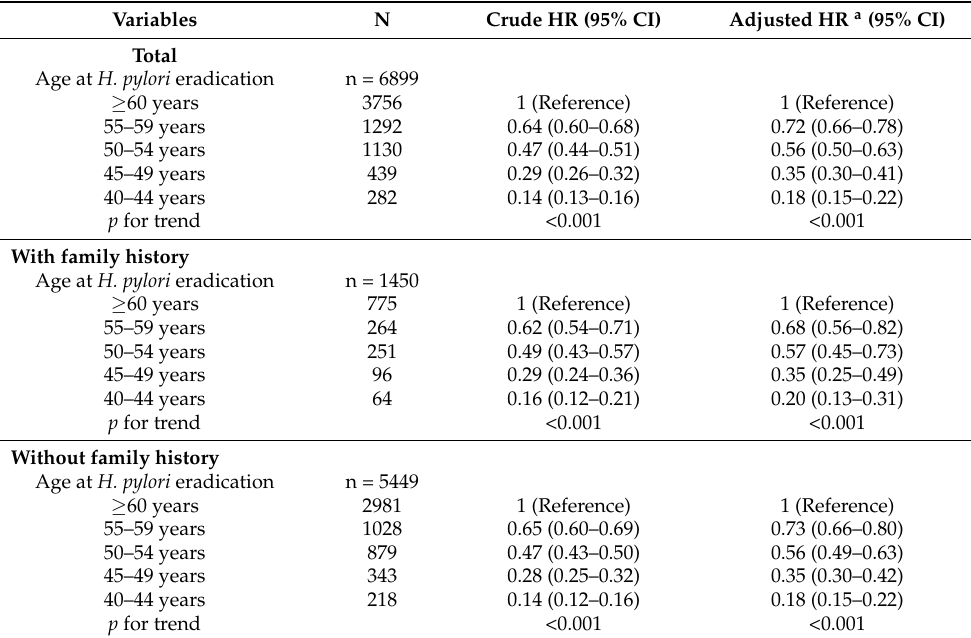
Table 5. Risk of gastric adenoma according to the age at H. pylori eradication in total study population and the patients with and without family history of gastric